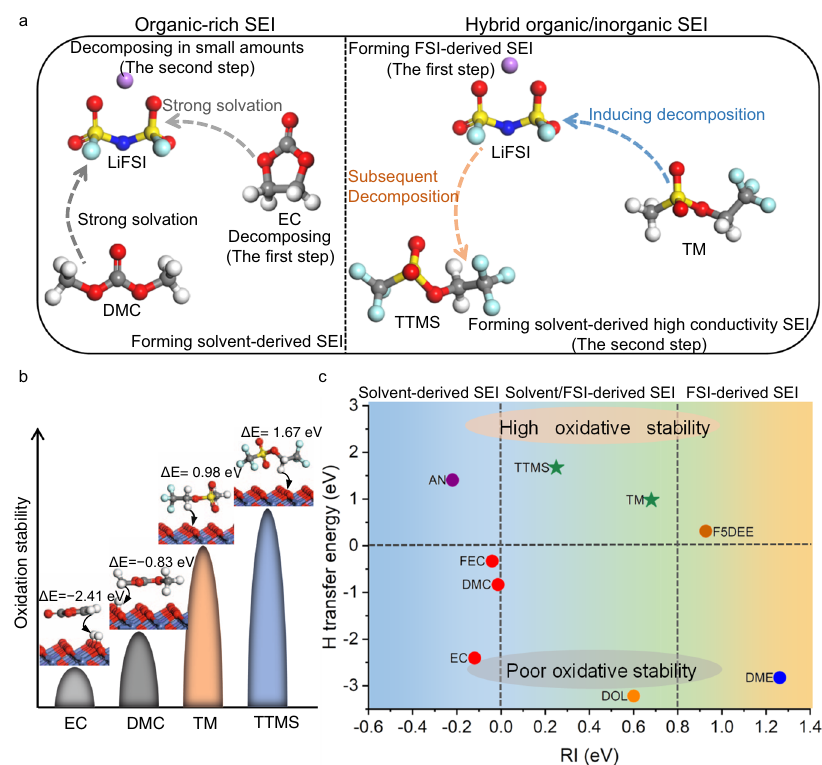
Fig. 7 | Design principles for high-voltage LIBs electrolyte. a Different kinds of SEIsformedongraphiteanodes. b Oxidationstabilityofdifferentsolventsatfully charged NCM811 surface. c Design principle of high-voltage LIB electrolytes. On the vertical axis, spontaneous H-abstraction occurs in the electrolytes below the horizontal dashed line (corresponding to 0eV), whereas non-spontaneous H- abstraction occurs in the electrolytes abovethe same line. On the horizontalaxis,